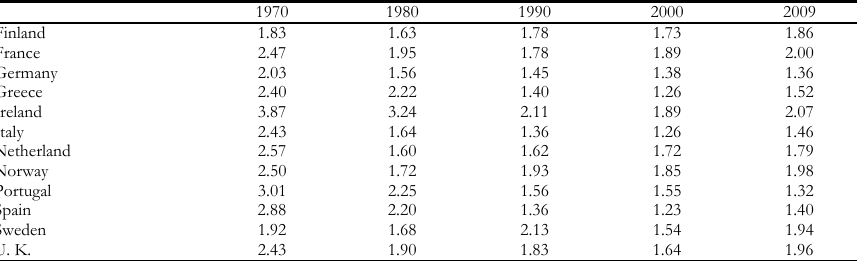
Total fertility rate for selected European countries, 1970-2009